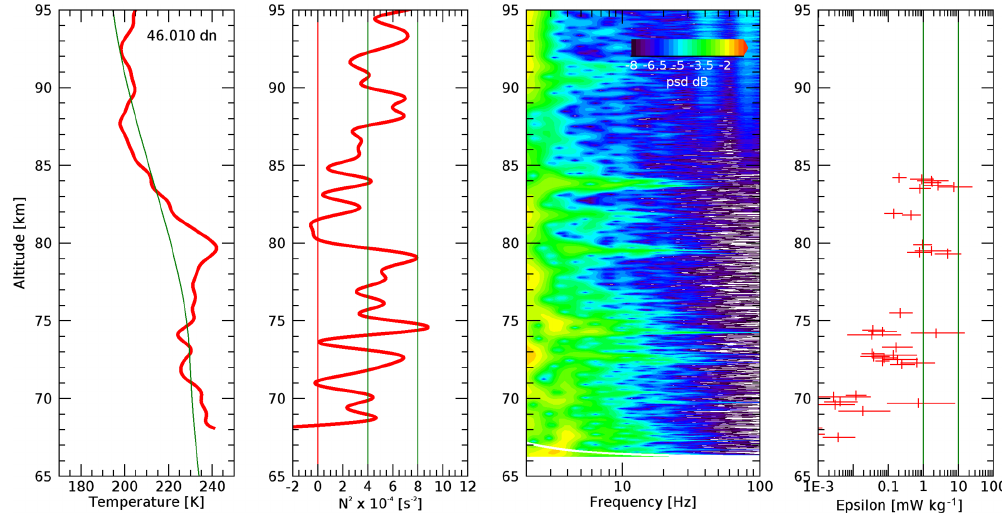
Figure 12. Same as Fig. 9 but for 46.010